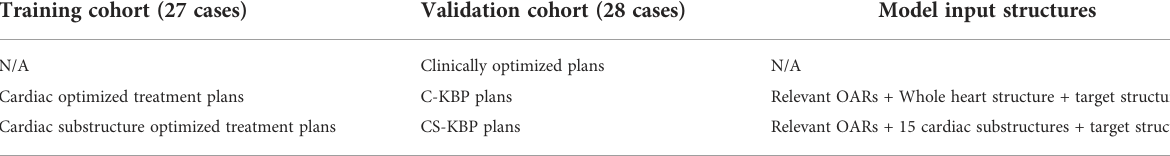
TABLE 1 Summary of three sets of validation cohort and corresponding input structures. Training cohort (27